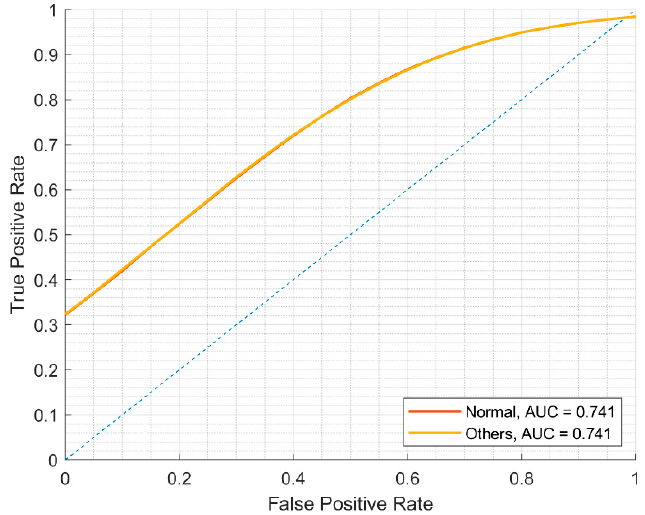
Figure 11. ROC curve of the first stage using ML.NET created model on UNSW-NB15 training dataset employing binary classification.